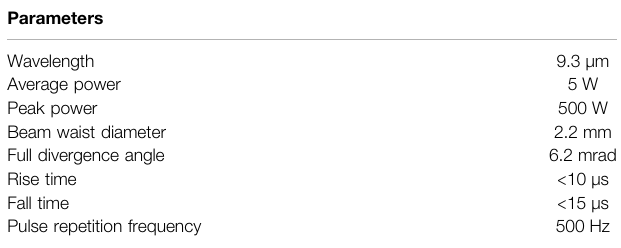
TABLE 1 | Parameters of the ultra-pulsed CO 2 laser osteotomy